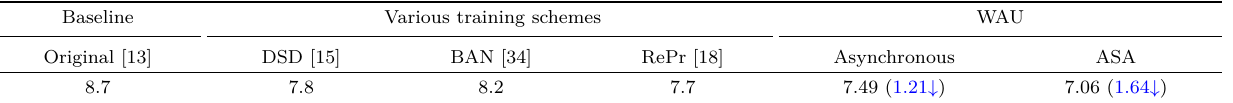
Table 5 Comparison of the test error (%) of WAU on CIFAR-10 with other related training strategies